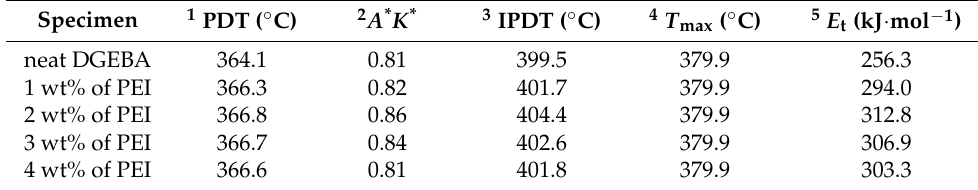
Table 1. Thermal stability parameters of the DGEBA/PEI